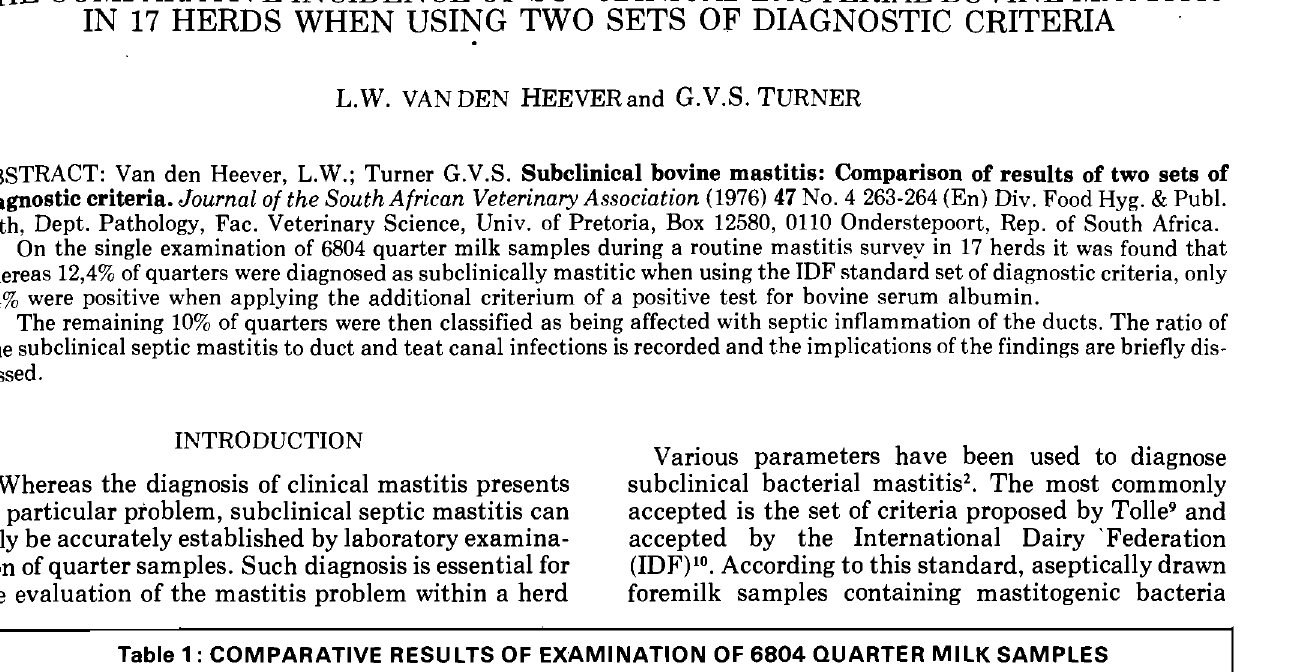
Table 1: COMPARATIVE RESULTS OF EXAMINATION OF 6804 OUARTER MILK SAMPLES (OMS) FROM COWS IN 17 FRIESLAND-TYPE DAIRY HERDS No.